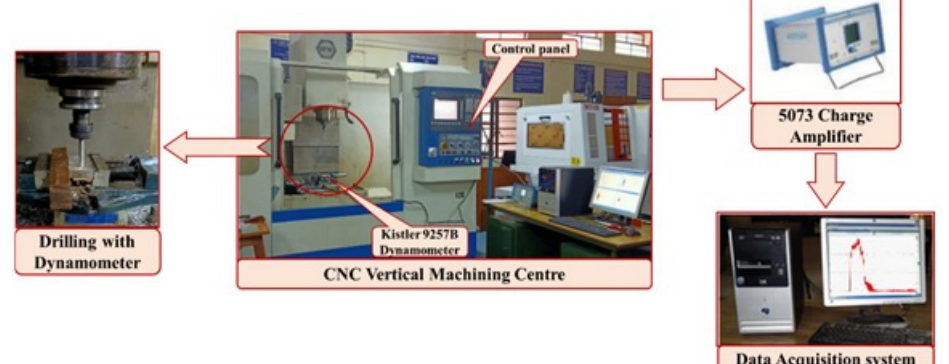
Metals 2021 , 11 , x FOR PEER REVIEW Figure 3. Experimental setup measuring thrust force and torque during drilling.